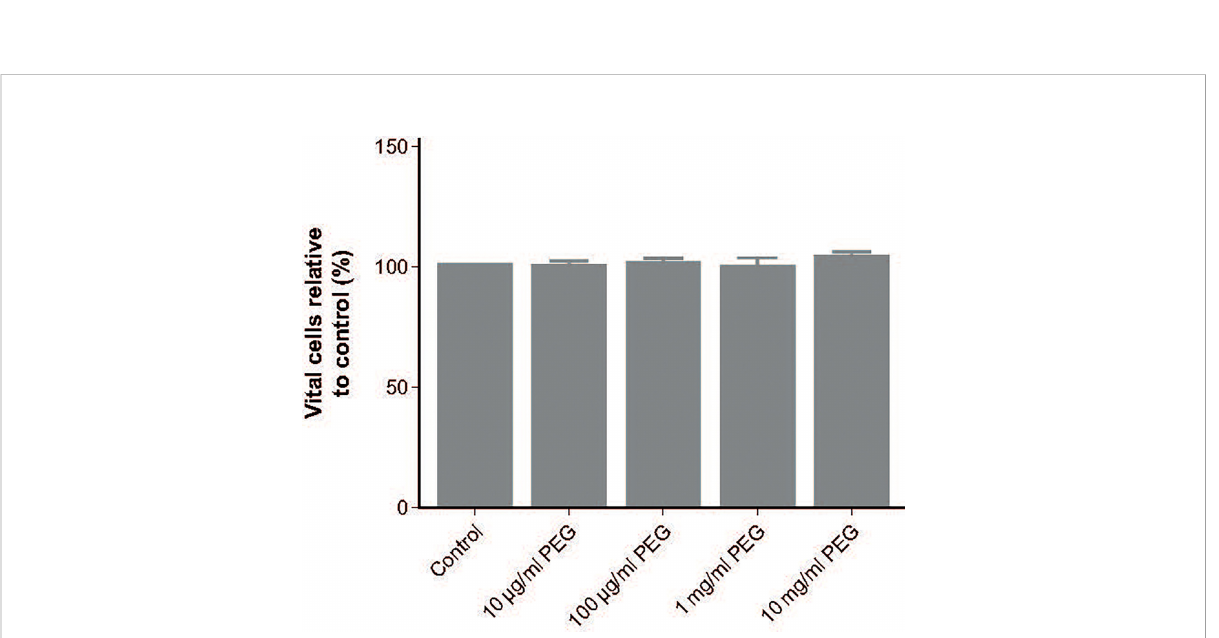
FIGURE 6 Effect of 20-kDa PEG exposure on viability of human MDMs. Mean (SD) vital cells (negative for Annexin V and propidium iodide) after 24 hours of PEG exposure, relative to control (n = 5). MDM, monocyte-derived macrophage; PEG, polyethylene glycol; SD, standard